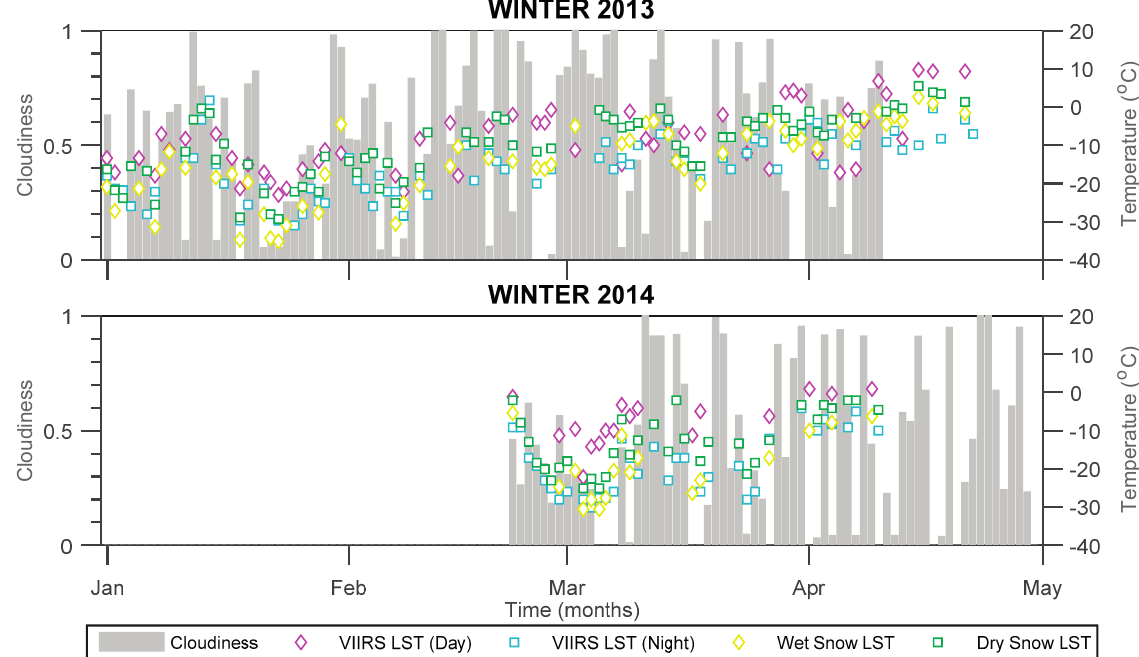
Figure 14. VIIRS LST daytime and nighttime views and inversely retrieved LSTs (wet and dry snow conditions) using the empirical formulas derived from the linear regression models in Section 3.4. Sky cover in the background.